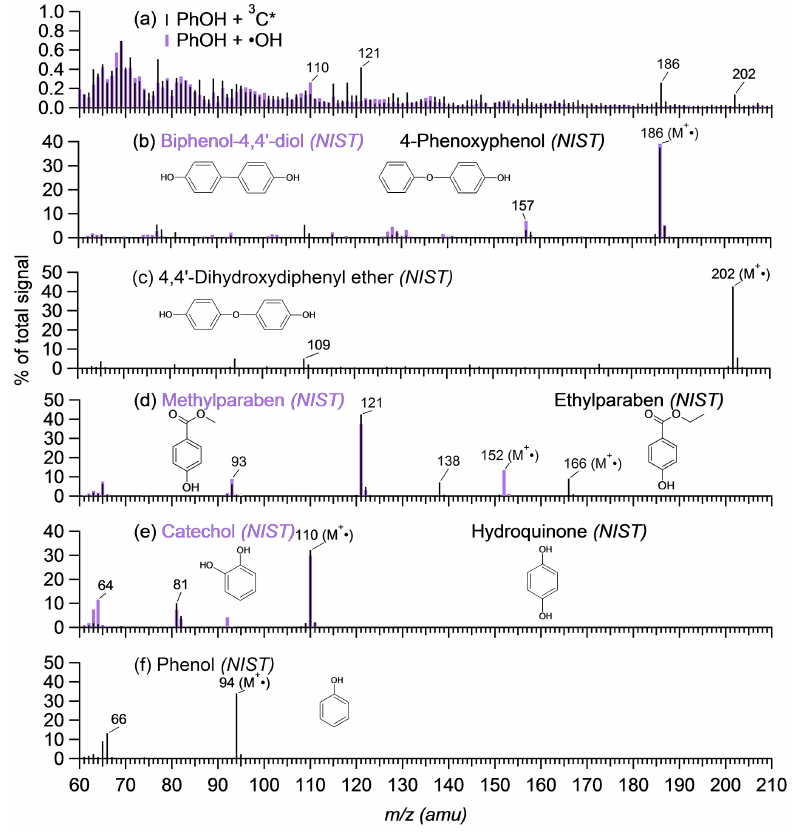
Figure 6. Comparisons between (a) the AMS mass spectra (in integer m/z) of phenol (PhOH) aqSOA formed via reactions with 3 C ∗ and · OH, respectively, and the NIST mass spectra of (b) biphenol-4,4 (cid:48) -diol and 4-phenoxyphenol, (c) 4,4 (cid:48) -dihydroxydiphenyl ether, (d) methylparaben and ethylparaben, (e) catechol and hydroquinone, and (f) phenol. The chemical structures for each compound are shown and the molecular ions (M + · ) are